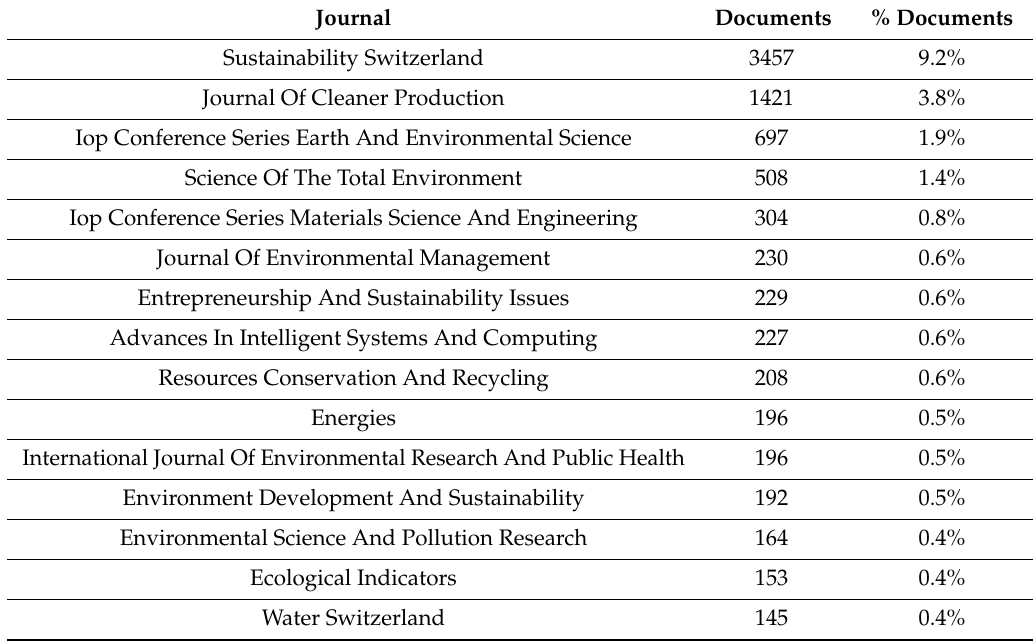
Table 8. Journals on sustainability between 2019 and